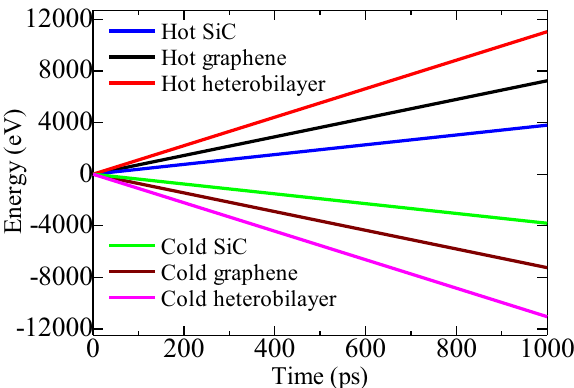
Figure 4. Aggregated energy added to the hot region and extracted from the cold region as a function of